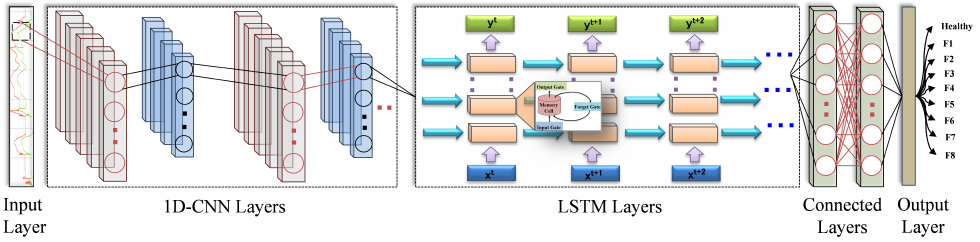
Figure 5. Deep neural network architecture of the proposed model.